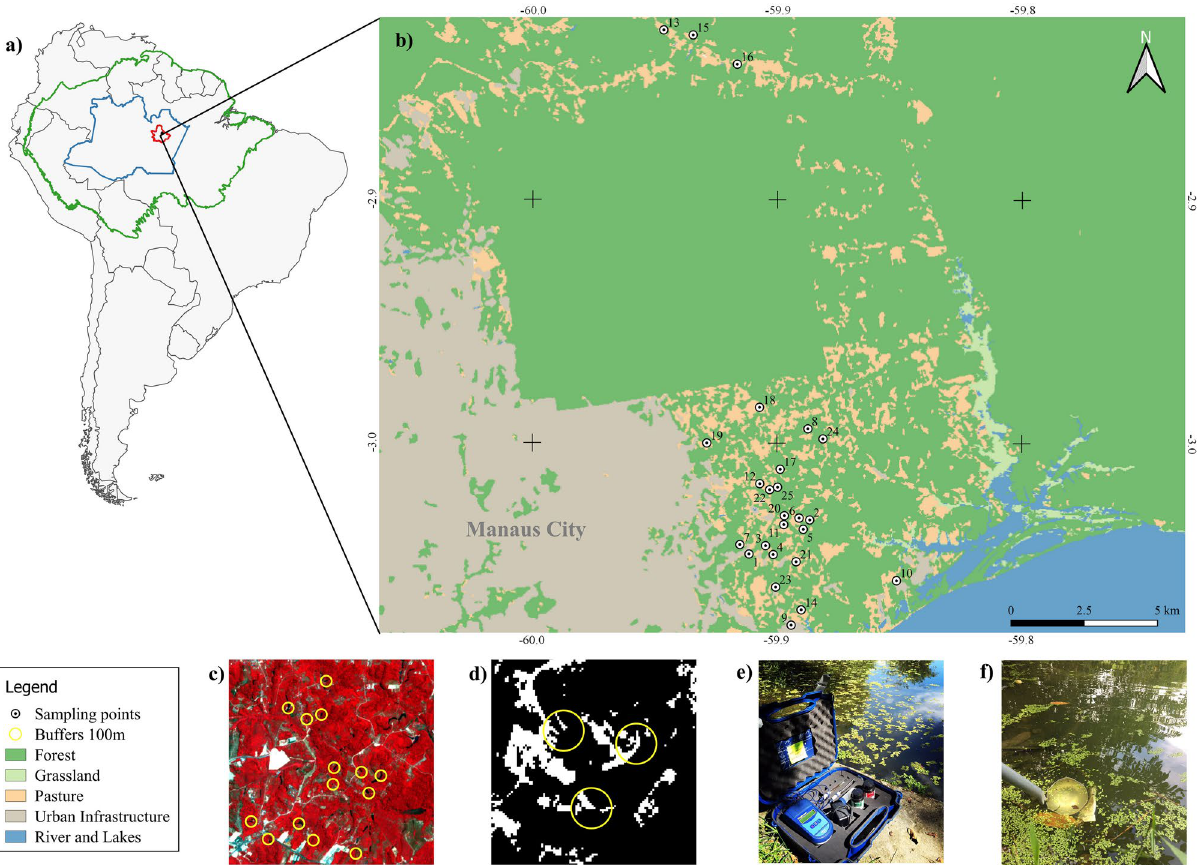
Figure 2. Locations of artificial larval Anopheles habitats in the Manaus periurban area. ( a ) Amazon River basin with the delineation of Amazonas state and Manaus; ( b ) sites, cover and land use; ( c ) composition of